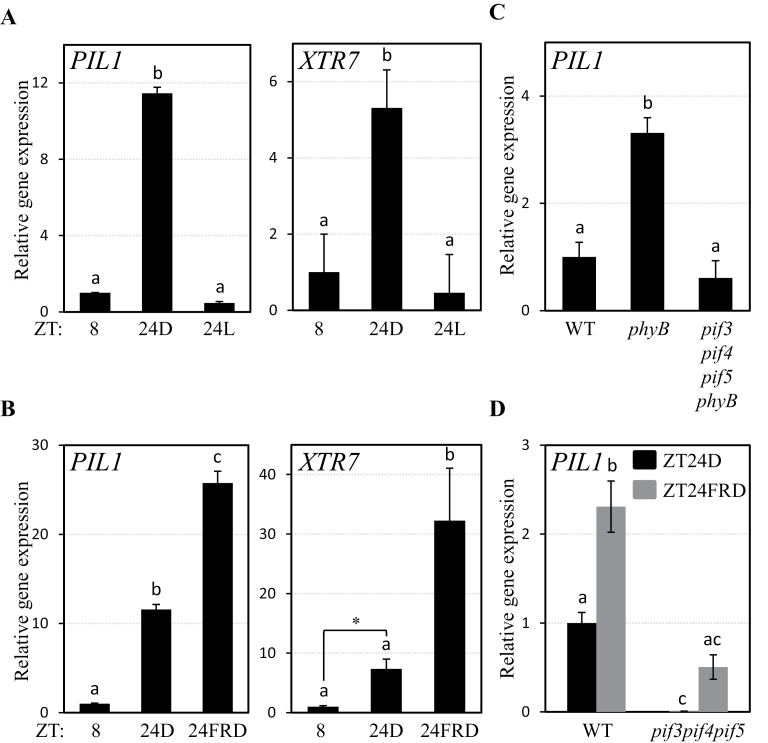
Correlation of growth marker gene expression with hypocotyl growth and levels of PIF3 under SD conditions. (A) Expression of PIL1 and XTR7 in seedlings grown as detailed in Fig. 1A. (B) Expression of PIL1 and XTR7 in samples grown as detailed in Fig. 2A. (C) Expression of PIL1 in 3-day-old SD-grown WT, phyB, and pif3pif4pif5phyB. (D) Expression of PIL1 in seedlings grown as detailed in Fig. 2A. The numerical value for pif3pif4pif5 at ZT24D is <0.01. Expression of PIL1 and XTR7 was analysed by quantitative RT–PCR, and values were normalized to PP2A. Different letters denote significant differences among means (P < 0.05). Comparison between XTR7 expression at ZT8 and ZT24D in B fell short of statistical significance under the stringent Tukey-b statistical test but showed a statistically significant difference (P < 0.05) by Student’s t-test (indicated with an asterisk).